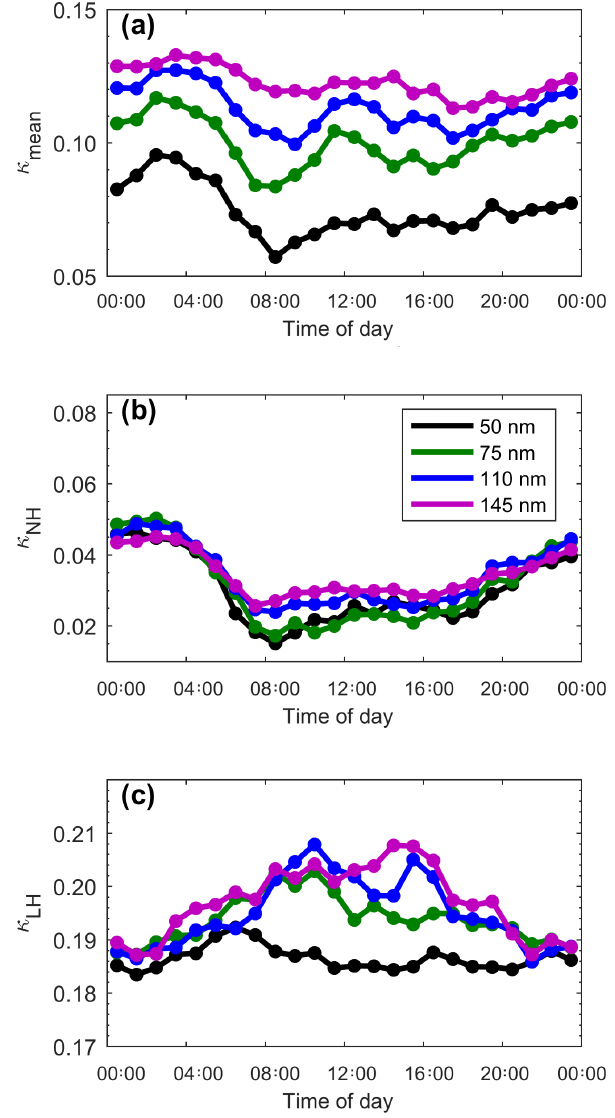
Figure 4. Mean diurnal variation of the hygroscopicity parameter κ for all data ( κ mean ; a ), separately for the nearly hydrophobic mode ( κ NH ; b ) and less hygroscopic mode ( κ LH ; c ) for different dry par- ticle diameters. The panels have shared legends.